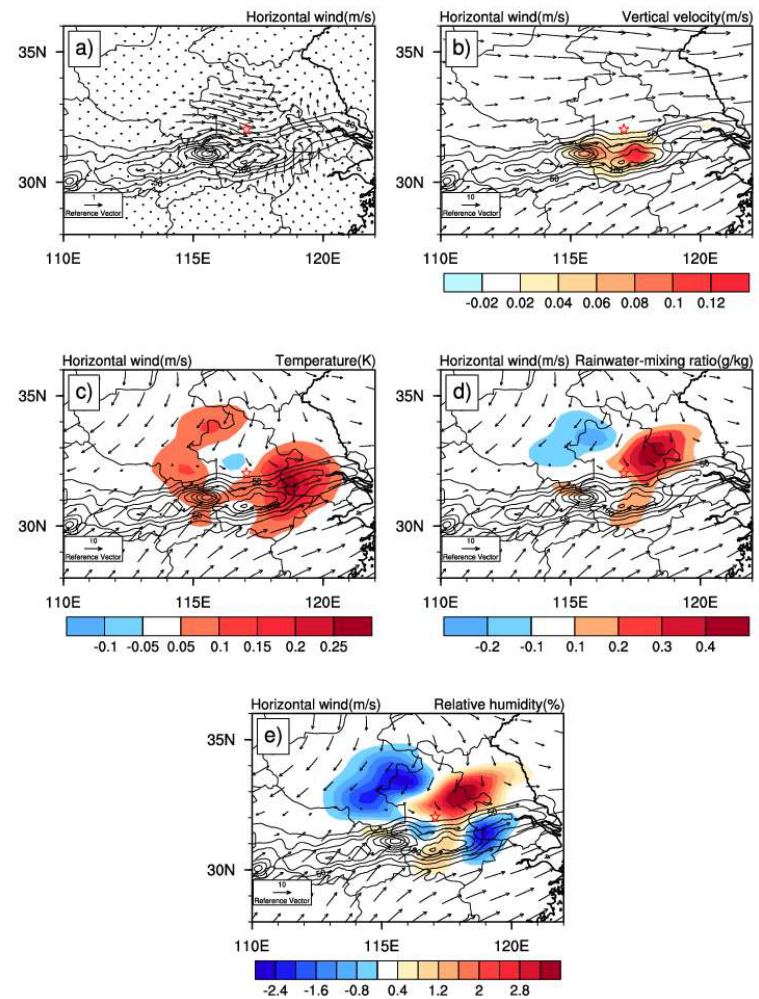
Figure 4. Increments at 00:00 UTC on 29 June 2009 from single observation experiment 1 (SOE1) ( a ) 500 hPa horizontal wind vector ( b ) 500 hPa vertical velocity (m s − 1 ) and background horizontal wind vector ( c ) 700 hPa temperature (K) and background horizontal wind vector ( d ) 700 hPa rainwater-mixing ratio (g/kg) and background horizontal wind vector ( e ) 700 hPa relative humidity (%) and background horizontal wind vector. The horizontal location of the single observation is marked by the red star and contour lines are the 24 h accumulated observed